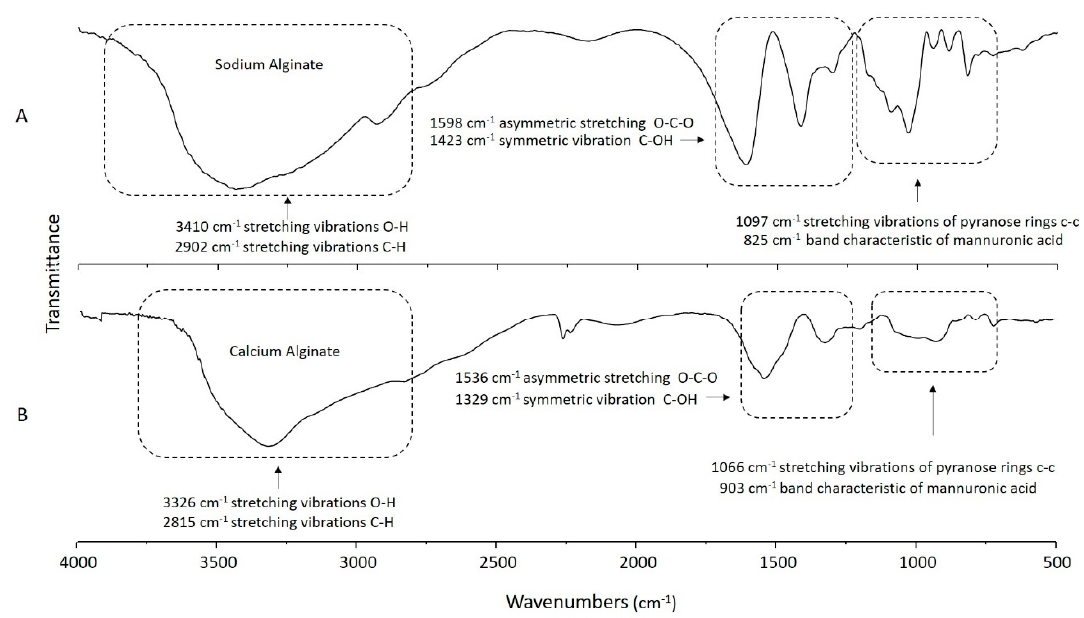
Figure 2. FTIR spectra of ( A ) Na-alginate, ( B ) Ca-alginate.